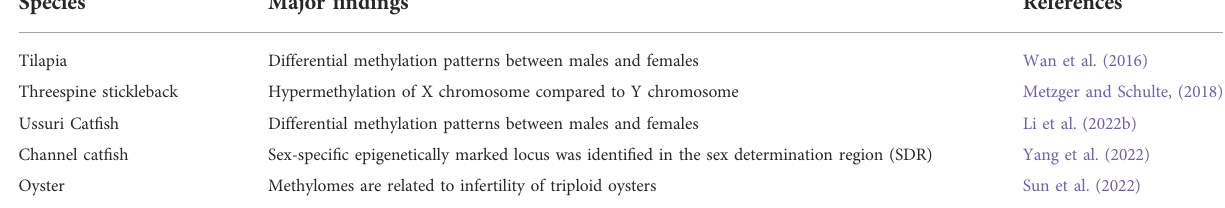
TABLE 4 Sexual dimorphism in patterns of DNA methylation.